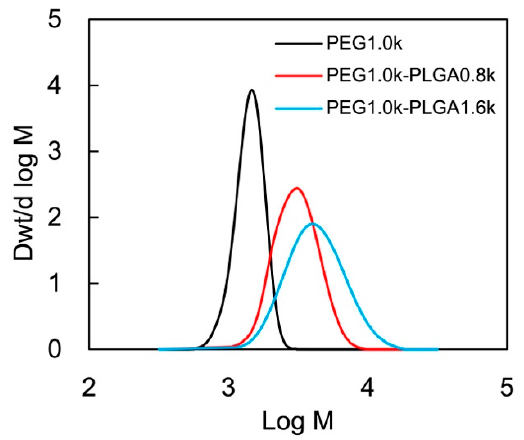
Figure 2. Molecular weight distributions of PEG and the synthesized PEG- b -PLGA diblock copolymers determined by GPC.